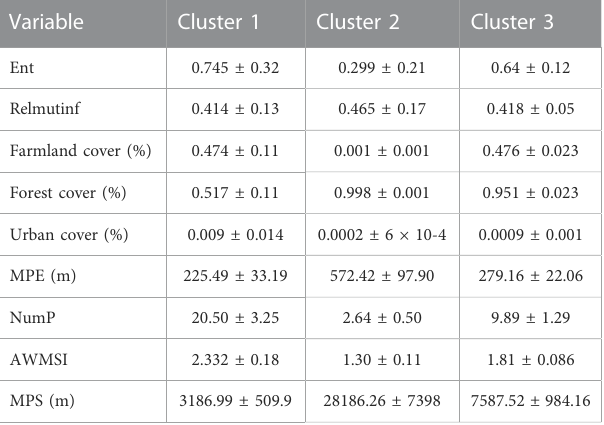
TABLE 4 Center values for every cluster and 95% con fi dence intervals in the Central Conservation Area of Costa Rica, 2019 –